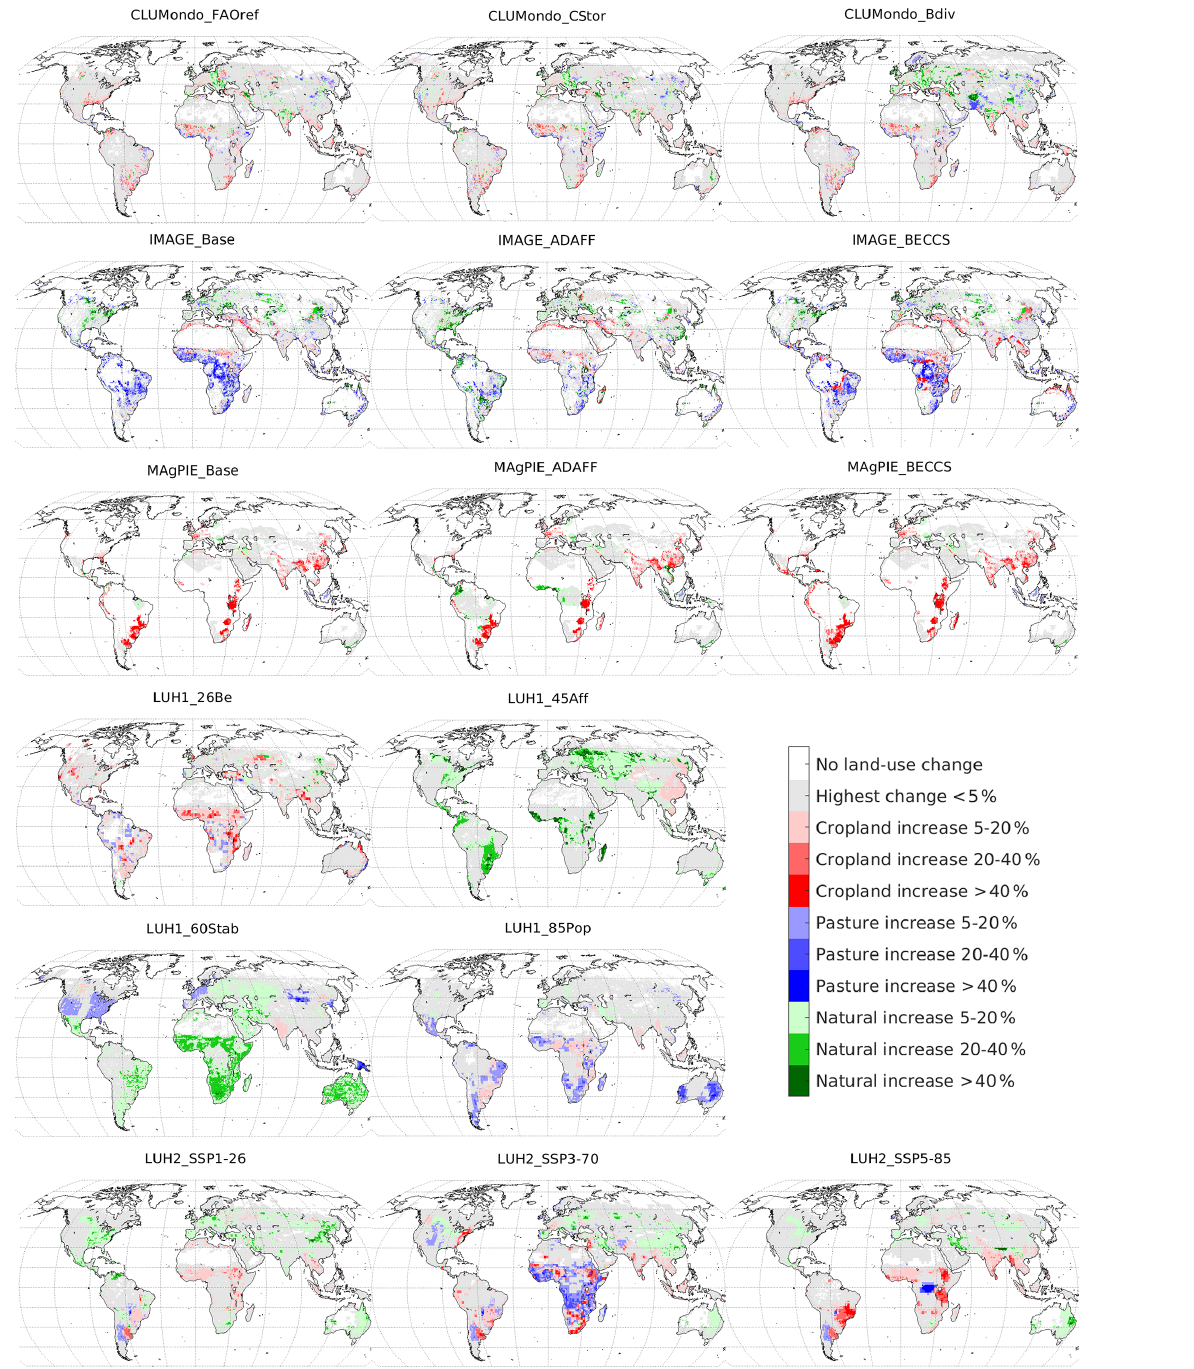
Figure 2. Categories of dominant land-use change from 2000–2004 to 2036–2040 for each of 16 land-use scenarios. The legend is identical for all